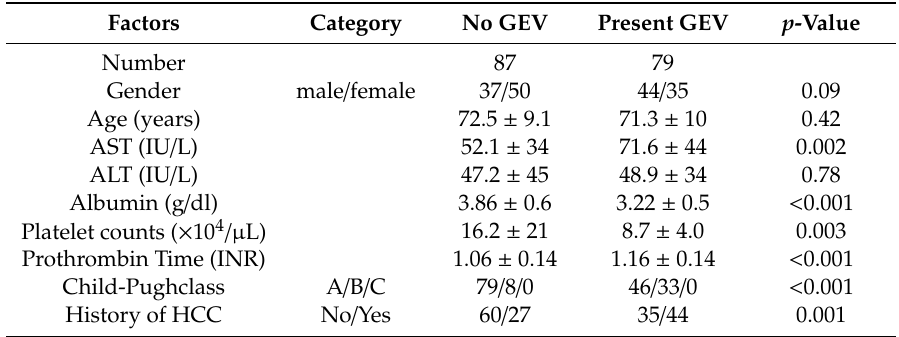
Table 1. Patient